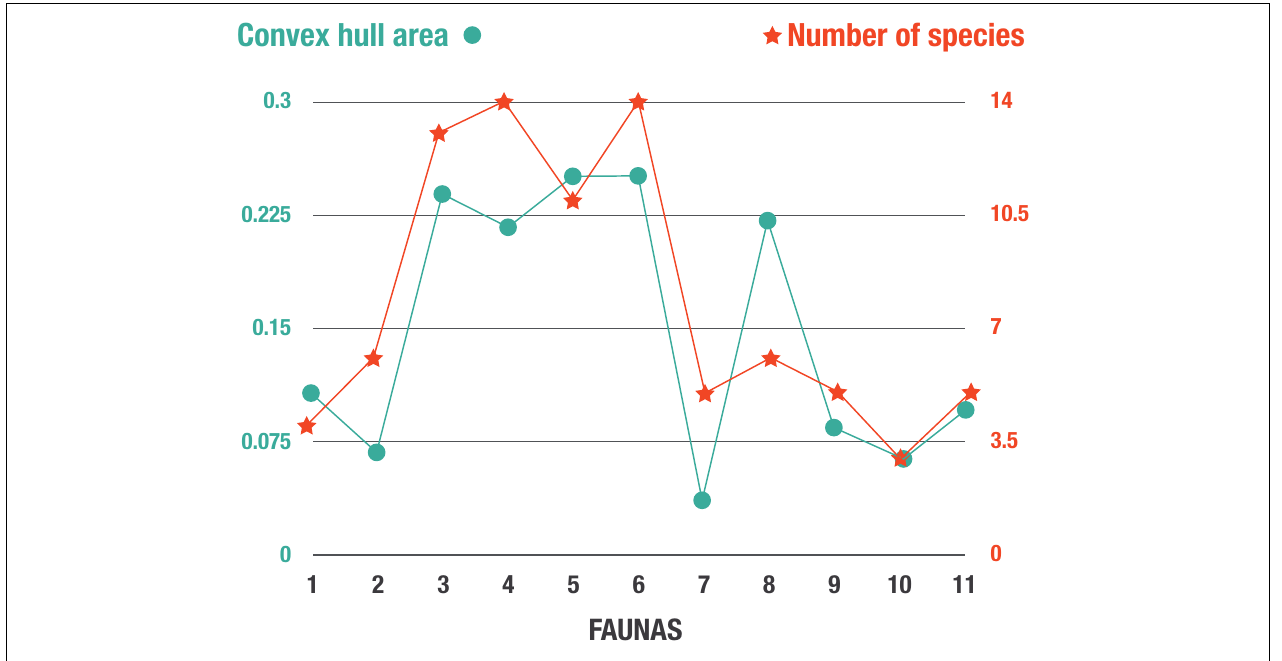
FIGURE 7 | Plot of the convex hull area (used as a proxy for disparity) vs. the number of artiodactyl species (diversity) in the faunas of the Neogene of North America. Fauna numbers as in Figure 2 .